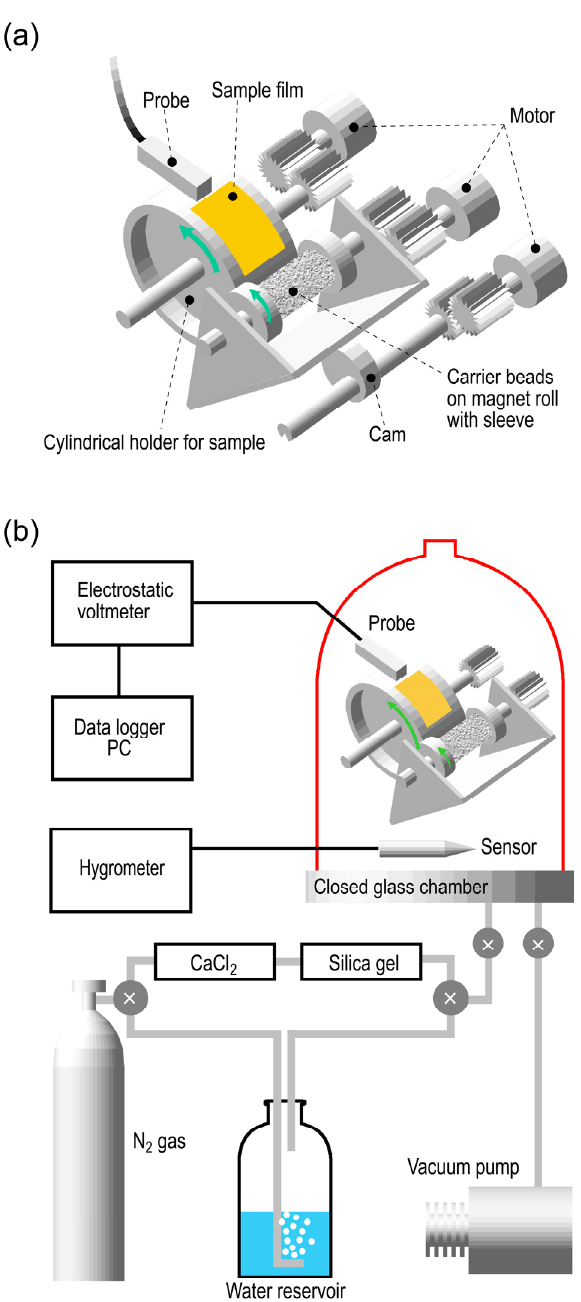
Figure 2. Apparatus ( a ) and measuring system ( b ) for the triboelectric charging of polymer